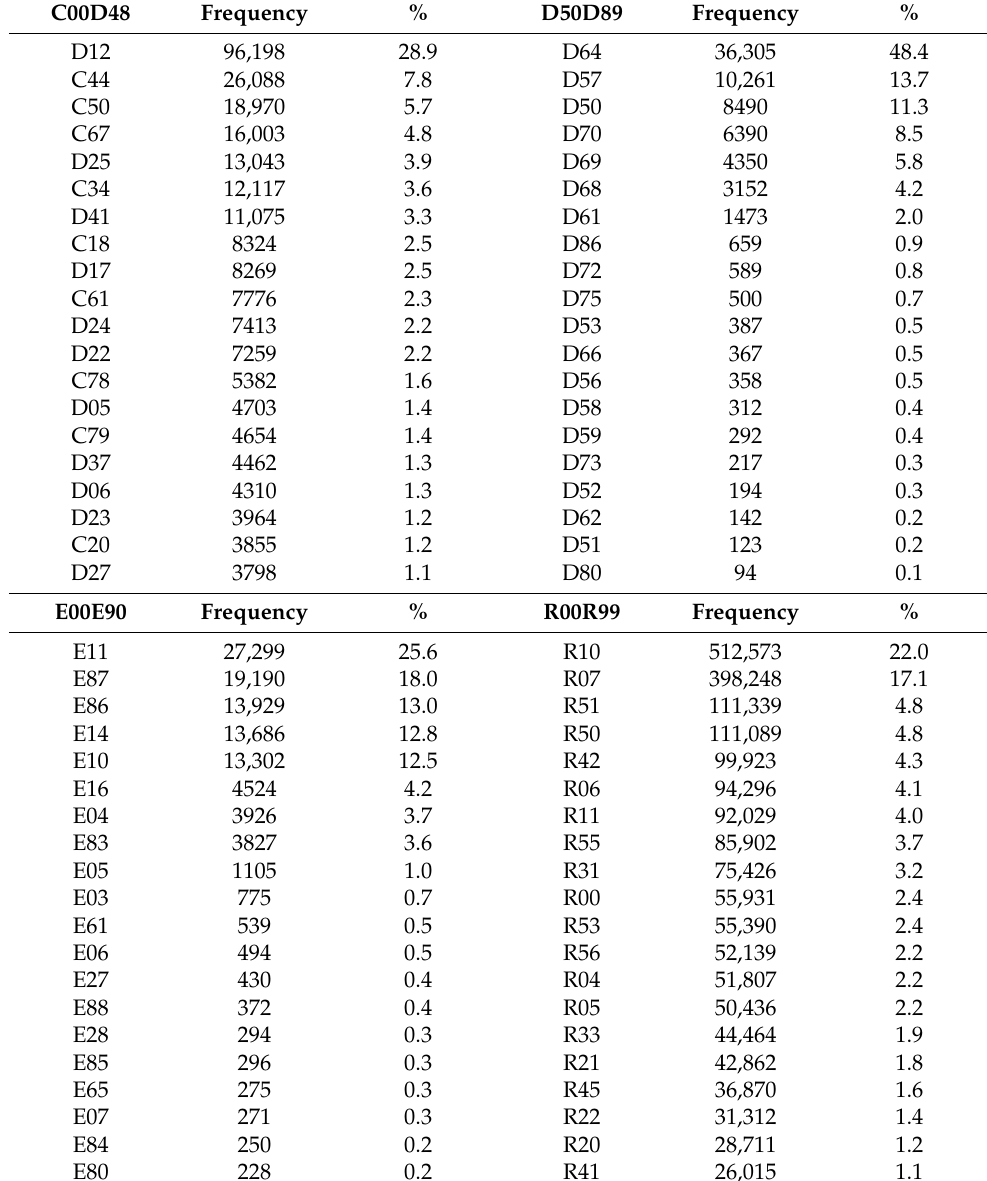
Table 1. Top 20 frequencies of ED visits classified in Chapters II and